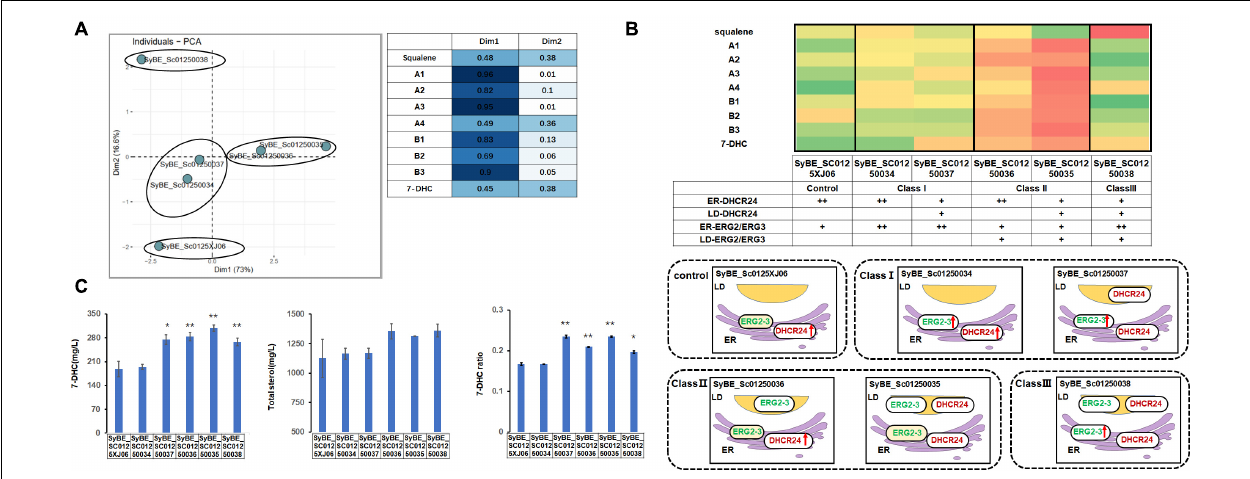
FIGURE 3 | Compartmentalized reconstitution of downstream post-squalene enzymes. (A) Principal component analysis (PCA) of sterol intermediates of the strains under compartmentalized reconstitution of downstream ERG enzymes (after B1). Different classes of strains are circled by ellipses. The table shows the composition of the two principal components in the PCA experiment (Dim1 and Dim2). (B) The post-squalene pathway metabolic flux heat map. The accumulation levels of post-squalene intermediates were normalized according to Y = (X – µ )/ σ , where Y represents the normalized value, X represents the original value, µ represents the mean value, and σ represents the standard deviation. The larger Y is presented by a color that is close to red, while the smaller one is close to green. The locations of engineered ERG proteins in the constructed strains are presented below the heat map. Backgrounds of the enzymes without modification are yellow. The up arrows represent protein overexpression. (C) 7-DHC productions, total sterols, and 7-DHC ratios of the constructed stains. All data were from at least triplicate experiments. T -test was conducted between the corresponding strain and the control strain SyBE_Sc0125XJ06. Significance levels of t -test: * P < 0.05, ** P <